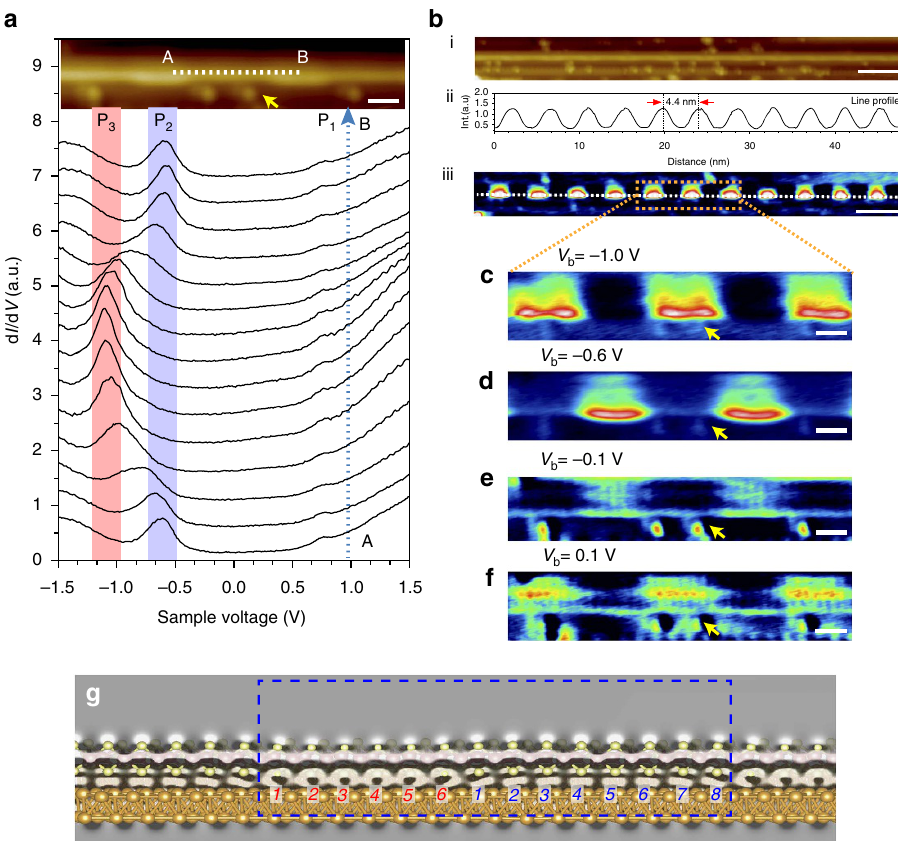
Figure 3 | Oscillating electronic structures in a single MoS 2 nanowire. ( a ) A set of spatially-resolved STS spectra acquired along the axis of a single MoS 2 nanowire over one modulation periodicity (from A to B marked in the inset STM image, V b ¼ (cid:3) 0.6V, I t ¼ 150pA ). ( b , i) STM image and (iii) corresponding d I /d V mapping of an extended single MoS 2 nanowire ( V b ¼ (cid:3) 1.0V, I t ¼ 150pA); (ii) line profile along the single MoS 2 nanowire in d I /d V map shows a periodic electronic modulation. ( c – e ) Experimental d I /d V maps of the rectangle-enclosed region in b ,iii taken at different sample bias: ( c ) (cid:3) 1.0V, ( d ) (cid:3) 0.6V, ( e ) (cid:3) 0.1Vand ( f ) 0.1V . The same position is marked by yellow arrows in STM image and corresponding d I /d V maps. ( g ) DFTcalculation of the charge distribution in the single MoS 2 nanowire reveals the (6,8) pattern as highlighted by red and blue numbers. Blue dotted box demarcates a single modulation period. Scale bars, 5nm ( b ) and 1nm ( a , c – e